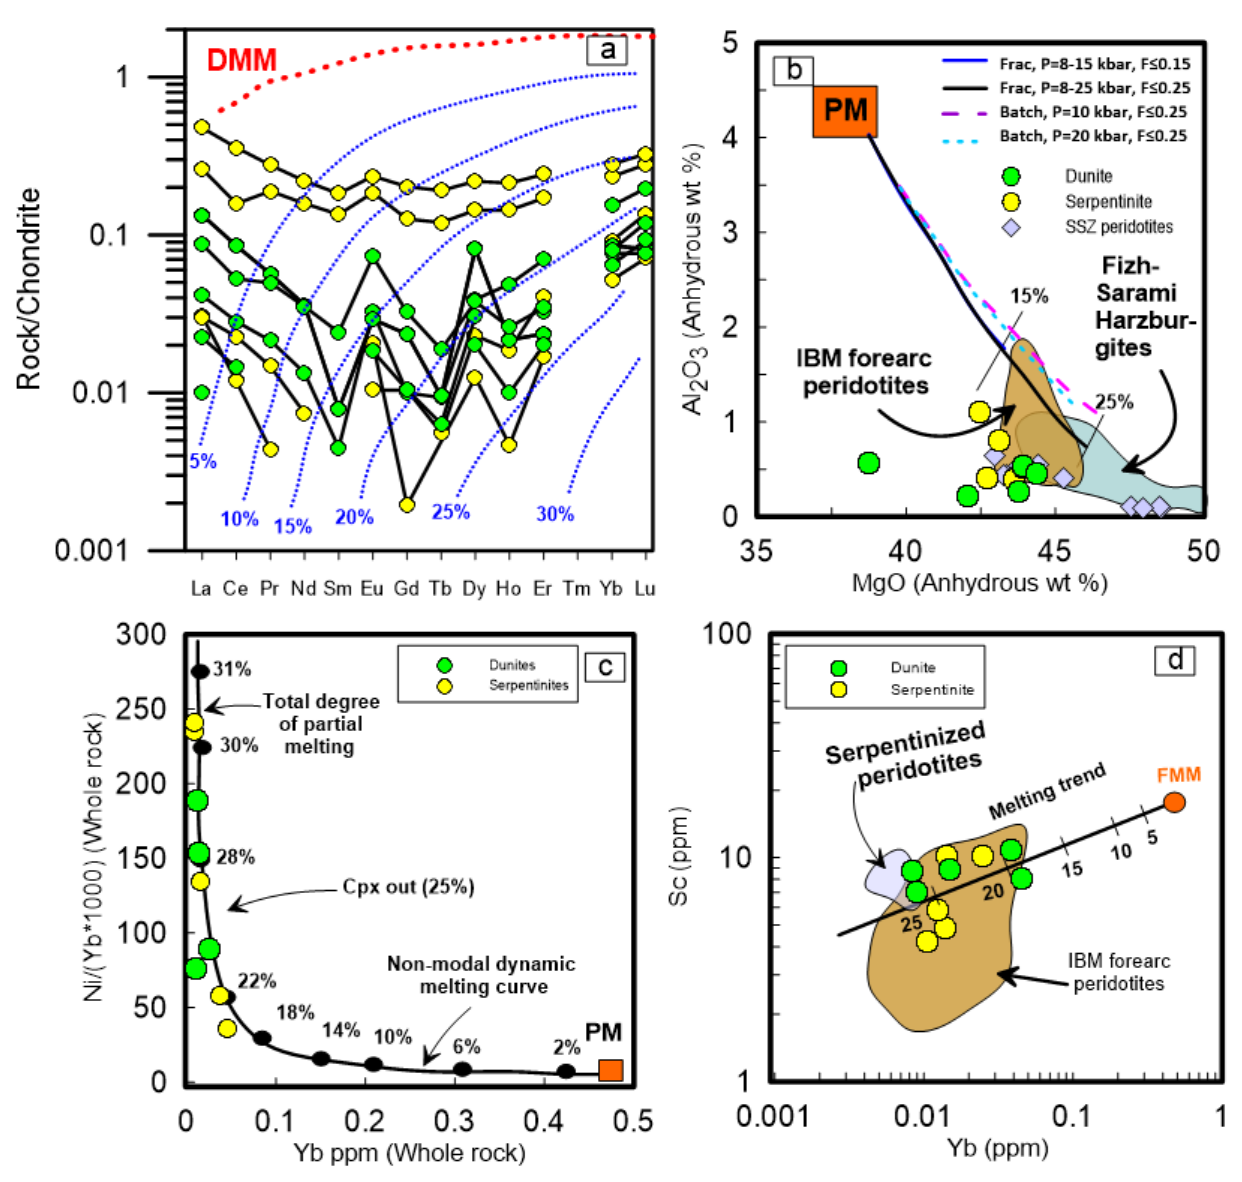
Figure 9. Estimation of partial melting degrees based on whole-rock chemistry. ( a ) Chondrite normalized [45] REE patterns of the studied dunites and serpentinites compared with the partial melting curves, supporting a source of depleted MORB mantle (DMM) composition [77] in the spinel stability field [78]; ( b ) MgO vs. Al 2 O 3 for the studied dunites and serpentinites. The isobaric batch melting (broken lines) and near-fractional polybaric melting (solid lines) calculations are based on the mantle melting model [83]; ( c ) Non-modal dynamic melting of a primitive mantle (PM) source [88] (after Kapsiotis [84]) for the studied peridotites; ( d ) Yb vs. Sc binary plot for residual peridotites [89]. Data of Izu-Bonin-Mariana (IBM) forearc peridotites [10], serpentinized peridotites [48], suprasubduction zone peridotites [46], and Fizh-Sarami (Oman) harzburgites [12,82] are used for comparison. The primitive mantle (PM) compositions are after McDonough and Sun [90] and Niu [43]. FMM = Fertile MORB mantle.